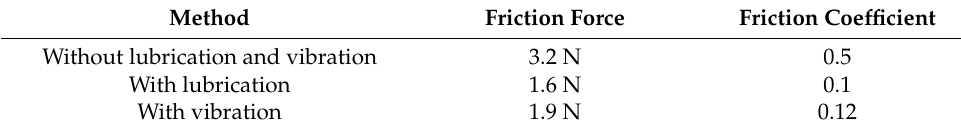
Table 3. Friction coefficient and friction force averaged measurement results.